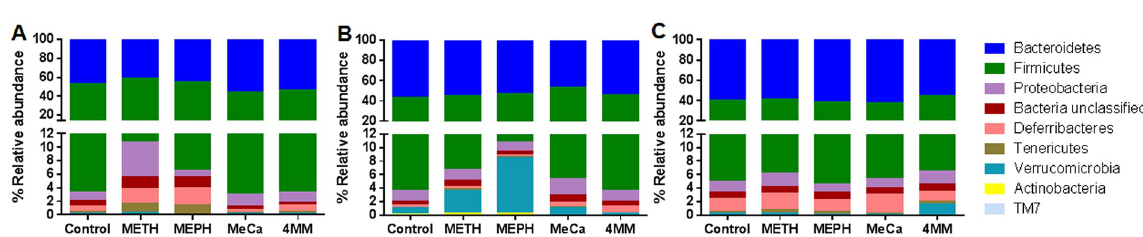
Fig 5. Relative abundances of phyla after treatment with study drugs. Results are presented as % relative abundance of each phylum for each study drug. Stacked columns for the 7 most prominent phyla are included for the 1- (A), 2- (B) or 7- day (C) time points after drug